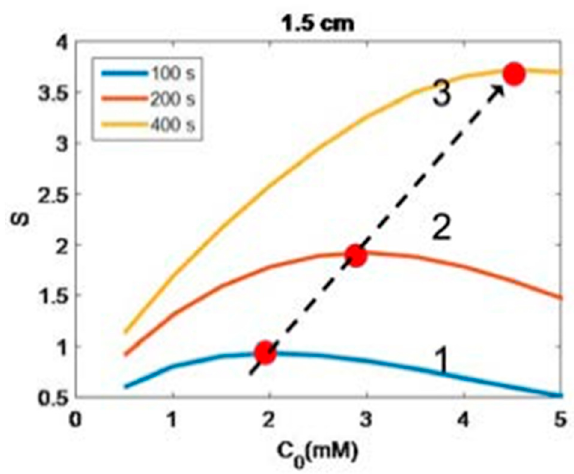
Figure 9. Numerical results of S versus PI concentration at various time, t = (100, 200, 400) s, for curves (1, 2, 3), at z = 1.5 cm; also shown are locations of the optimal concentrations (shown by red dots), which are increasing function of time (or light dose) (shown by dashed line).